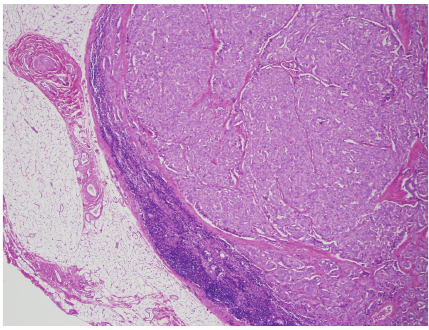
Figure4:Lowpowerviewofmetastatictumorwithinalymphnode. Table 2: 2010 WHO classification of neuroendocrine neoplasms